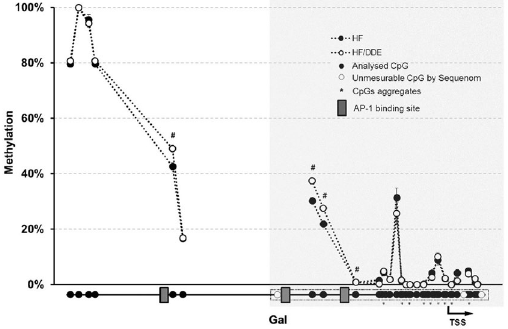
Figure 7. Methylation profile of galanin ( Gal ) promoter region in mesenteric vAT measured by Sequenom MassARRAY. The results are presented as average of percentage methylation ± SEM for each CpG site or aggregate of CpG sites. Statistical analysis unpaired t test: # p < 0.05. Gray area represents a CpG island. HF, high